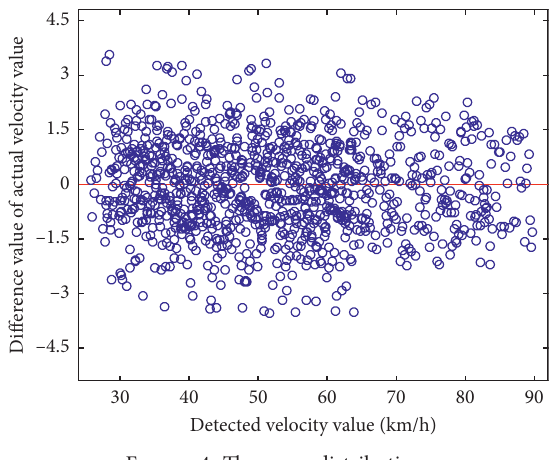
Figure 4: The error